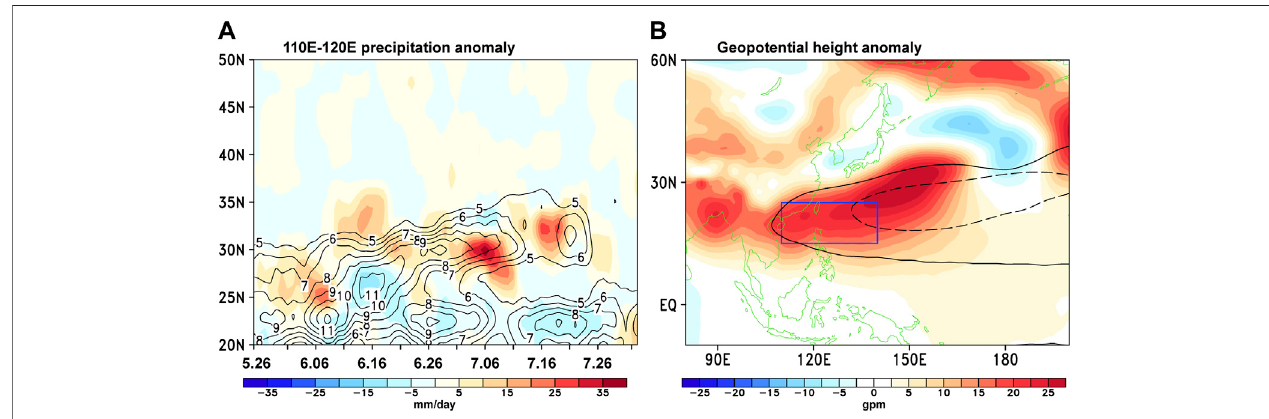
FIGURE 1 | (A) Time-latitude cross-section of the climatological precipitation (1981 – 2010, contour interval: 1 mm day − 1 ) and precipitation anomaly in 2020 (shading, mm day − 1 ) averaged over 110 ° E – 120 ° E from 26 May to 2 August. (B) Horizontal distribution of the geopotential height anomaly at 850 hPa in early summer 2020 (1 June – 31 July 2020, shading, gpm). Dashed and solid black lines in (B) represent the 5,880 gpm contour of the 500 hPa geopotential height in climatology and 2020, respectively. The blue box in (B) (110 ° E – 140 ° E, 15 ° N – 25 ° N) indicates the region of the western part of the western Paci fi c subtropical high (WPSH). Anomalies were computed based on the climatology of 1981 –